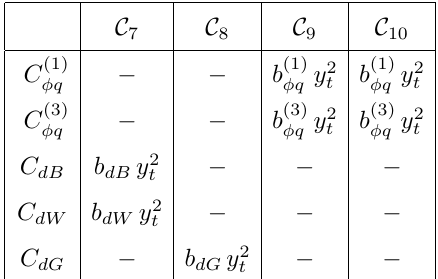
Table 3 . Tree-level SMEFT-to-WET matching relations in MFV with up-alignment. Shown are the flavor structures of the SMEFT contributions C ( m of O ( m ) or smaller have been neglected, including contributions to C s /m b O ( y s /y b )